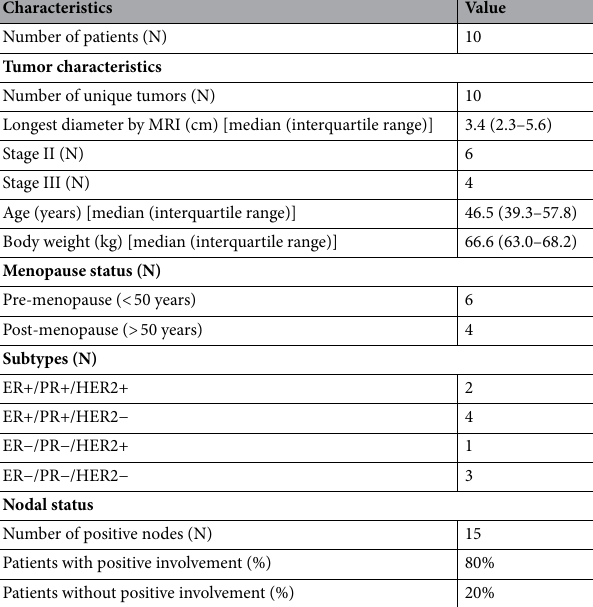
Table 1. Summary of patient and tumor characteristics. ER estrogen receptor, PR progesterone receptor, HER2 human epidermal growth factor-2, MRI magnetic resonance